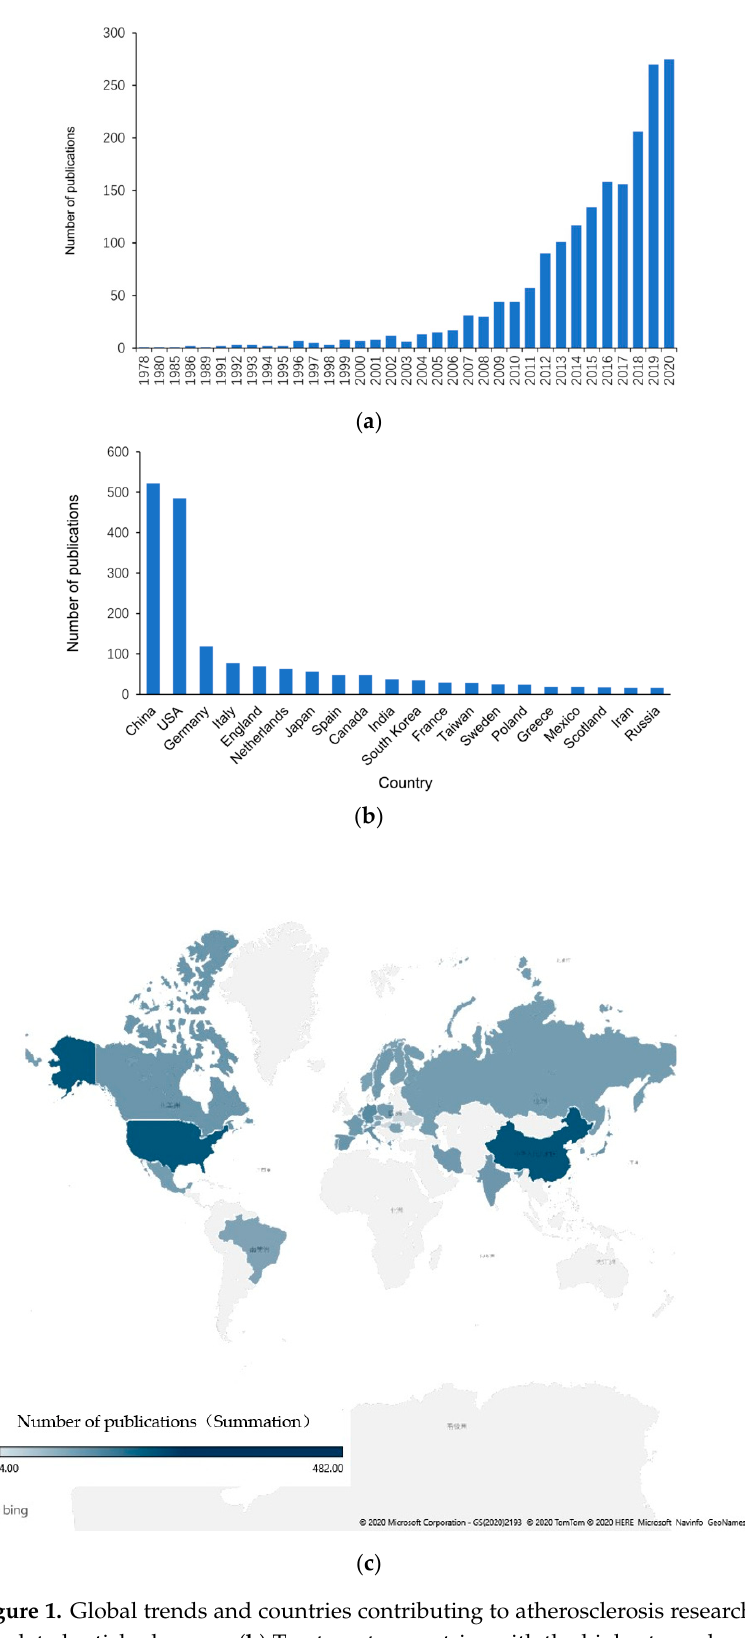
Figure 1. Global trends and countries contributing to atherosclerosis research. ( a ) Global number of related articles by year. ( b ) Top twenty countries with the highest number of published articles. ( c ) Global map showing countries where the articles were